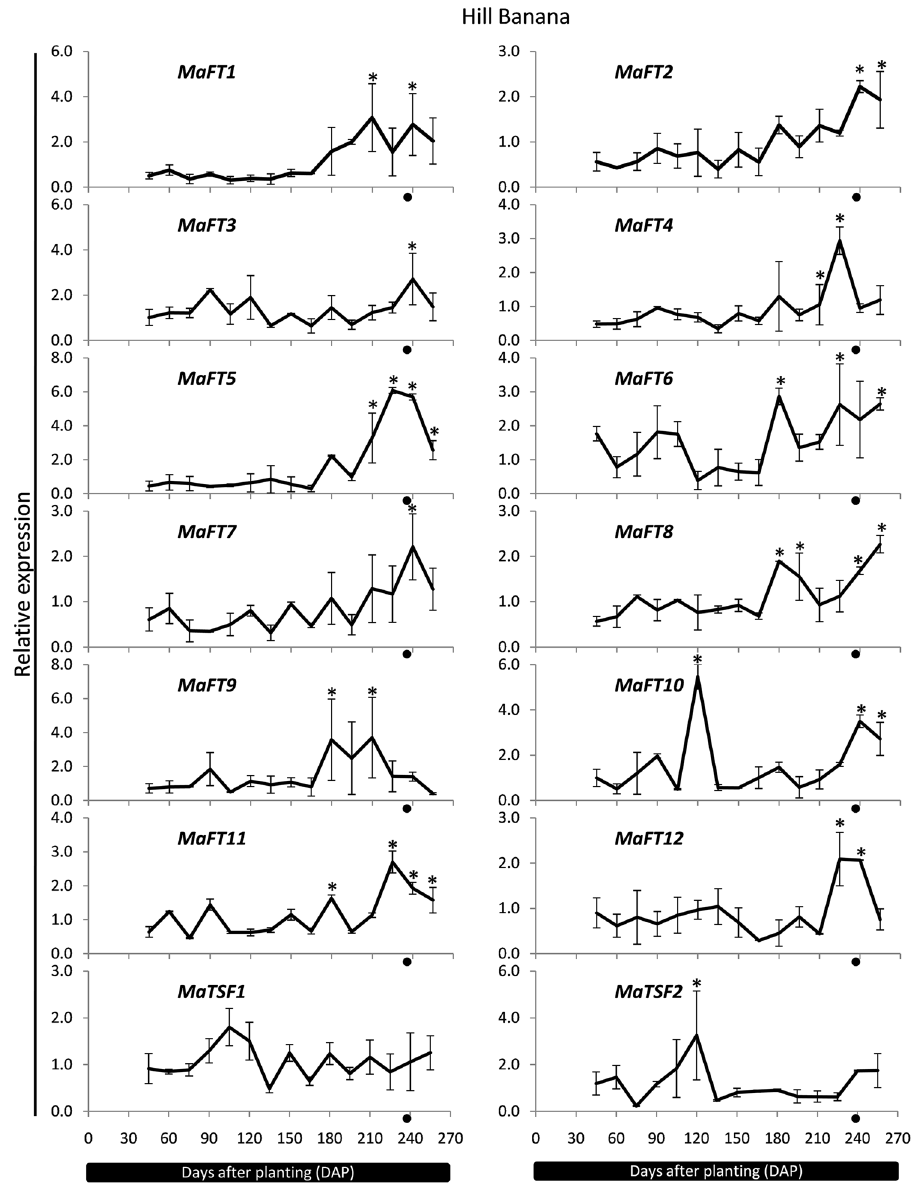
Figure 6. Time-course expression patterns of banana FT / TSF genes during development in Hill banana by qRT-PCR. The RPS2 gene of each is used as reference gene. The transition from vegetative to reproductive stage is shown by a black circle. The values are means of two biological (each containing a pool of leaves of five plants) and three technical replicates ( ± SE). Analysis was performed using the Tukey-Kramer multiple comparison test by GraphPad software. The asterisks ( * ) indicate significant differences (P <